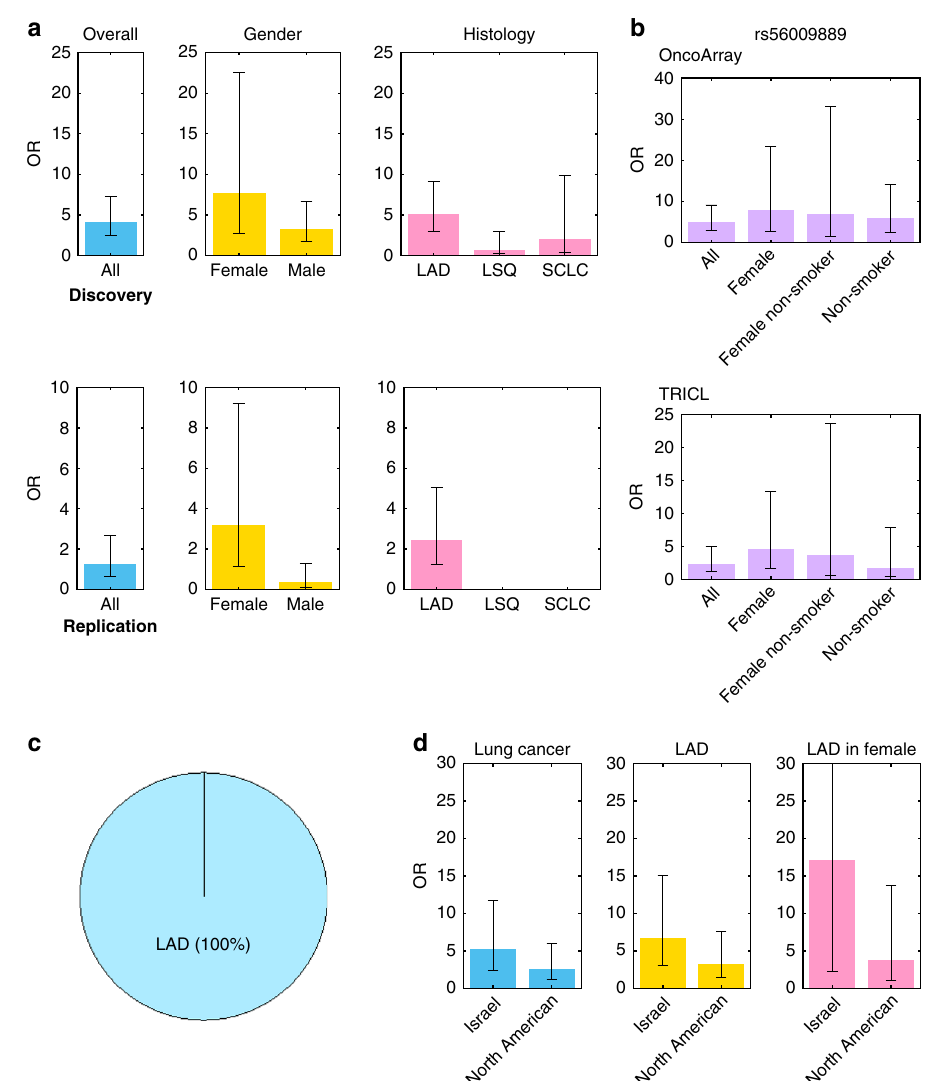
Fig. 2 ATM rs56009889 association with lung cancer risk. P values were determined by logistic regression analysis adjusted by age, gender, smoking status and the principal components. a Strati fi ed analyses of the association between rs56009889 and Lung cancer. Compared to non-carriers, L2307F carriers had an increased risk of lung cancer with ORs being 4.19 in the discovery data ( P = 3.56 × 10 − 7 , n = 28872) and 1.31 in the replication data ( P = 0.45, n = 10256). In females, L2307F carriers had a lung cancer risk with ORs being 7.76 in the discovery data ( P = 0.0002, n = 10919) and 3.22 in the replication data ( P = 0.03, n = 4698). L2307F carriers had a signi fi cant 5.2-fold increased risk for lung adenocarcinoma (LAD) in the discovery data ( P = 6.47 × 10 − 9 , n = 19356) and a 2.5-fold increased risk in the replication data ( P = 0.01, n = 7503). No associations of L2307F with the risk of lung squamous cell carcinoma (LSQ) ( n = 16853) or small cell lung cancer (SCLC) ( n = 14746) were observed in the discovery data. No L2307F variants were observed in LSQ or SCLC in the replication data. Colors indicate demographic and histological strati fi cations of the data. b Strati fi ed analyses of the association between rs56009889 and LAD. Females who carried L2307F had a >8-fold greater risk of LAD in the discovery dataset ( P = 0.0001, n = 8056) and a 4.7-fold risk of LAD in the replication data ( P = 0.004, n = 3680). Never smoking females who harbored L2307F had a 7-fold greater risk of LAD in the discovery data ( P = 0.01, n = 2817) and a 3.8-fold risk of LAD in the replication data ( P = 0.15, n = 1212). c Distribution of L2307F homozygotes. All the homozygotes of L2307F in the discovery data, no matter what age, gender, and smoking status, developed LAD in the discovery data. No homozygotes were found in the replication data. d Higher ORs of association between rs56009889 and the risk of lung cancer, of LAD in overall and in females were found in Israeli ( n = 1173) than in North Americas ( n = 10858). All of the associations have reached signi fi cant. The upper 95% CI of the LAD risk in female in Israel (adjusted OR = 17.15; 95% CI 2.24 – 131.32, n = 373) was not shown because it was too high. Colors indicate strati fi cations of the data by histology and sex. The error bars are OR ± the 95% CI values. Source data are provided as a Source Data fi Mutations and onset age of lung cancer . Carriers of L2307F dataset (68.74 ± 10.49 vs 63.69 ± 10.31, P = 0.09, Supplementary tended to be signi fi cantly older at lung cancer onset overall and in Table 13 and Fig. 4a). As ATM is more highly expressed at older all subsets except small-cell and squamous lung cancer in the age 17 the variant effects may be more pronounced at older ages, discovery data. For female lung AD, this effect was most pro- but larger datasets are needed to validate this observation. No nounced in the discovery dataset (69.37 ± 10.71 vs 62.78 ± 11.06, consistent variation in age by genotypes of rs150665432 was P = 0.0007) and showed borderline signi fi cance in the replication found overall or in subgroups (Supplementary Table 14).